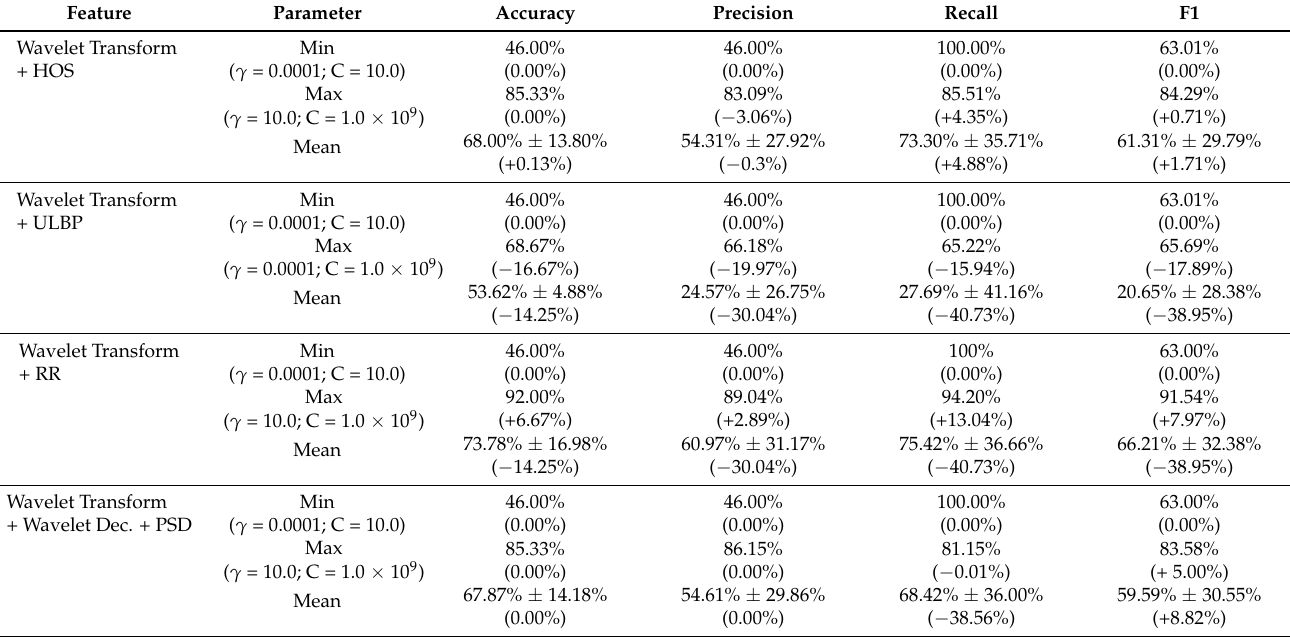
Table 4. Results obtained with combined handcrafted features for the